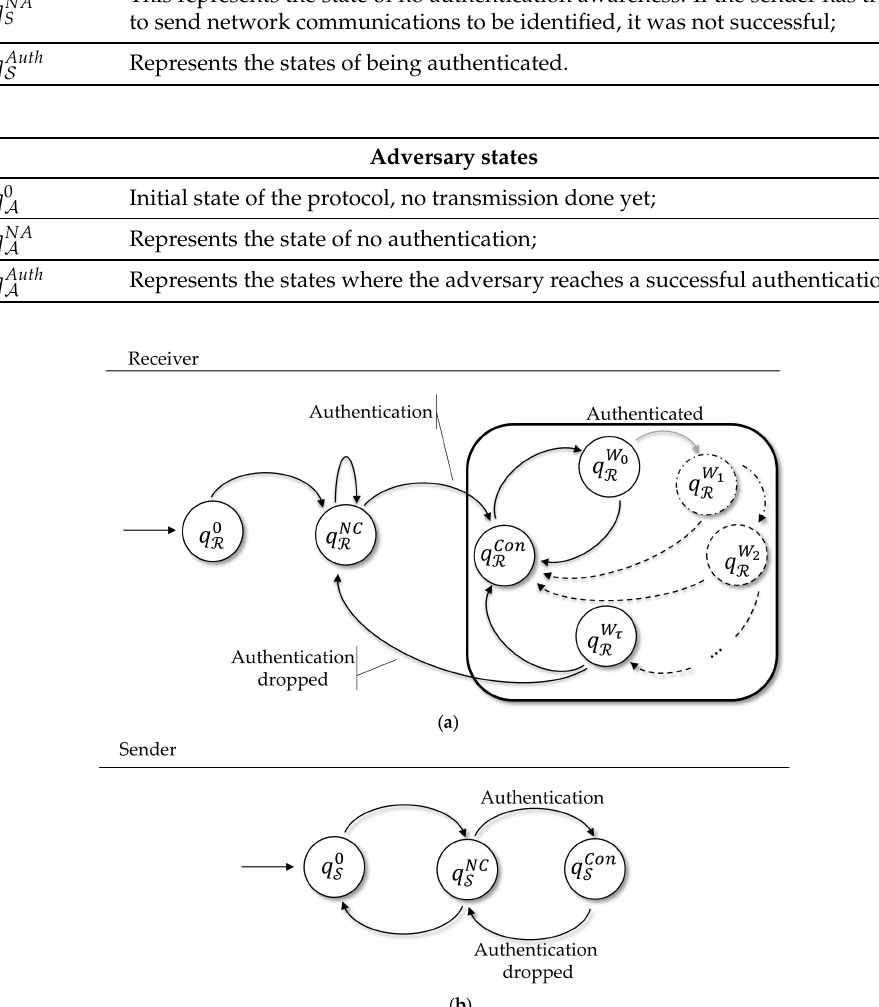
Figure 13. The finite state machine for the receiver ( a ) and the sender ( b ) in our proposed